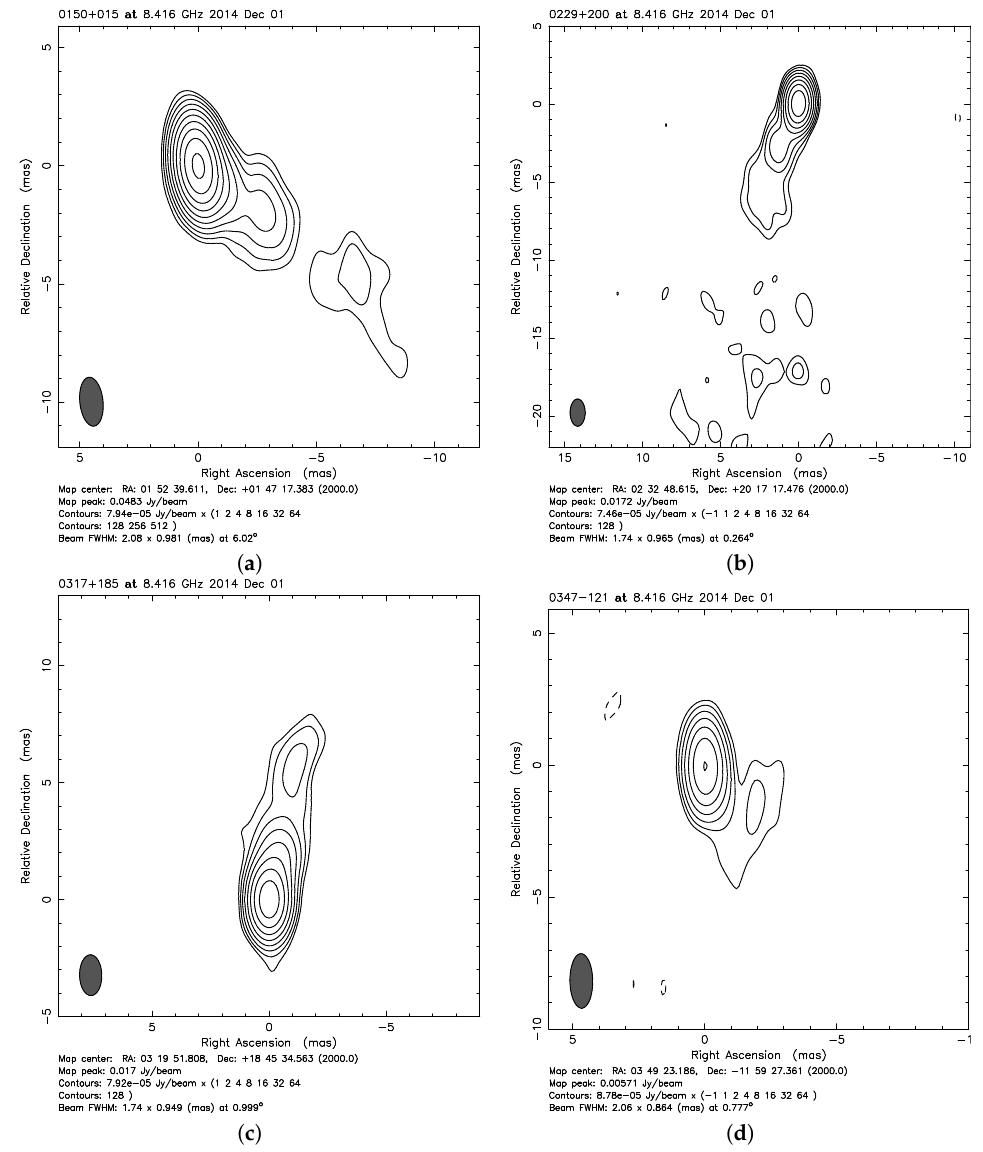
Figure 1. VLBA images at 8GHz of four Tev blazars in out VLBA monitoring program: ( a ) RGB J0152+017; ( b ) 1ES 0229+200; ( c ) RBS 0413 (0317+185); ( d ) 1ES 0347 −